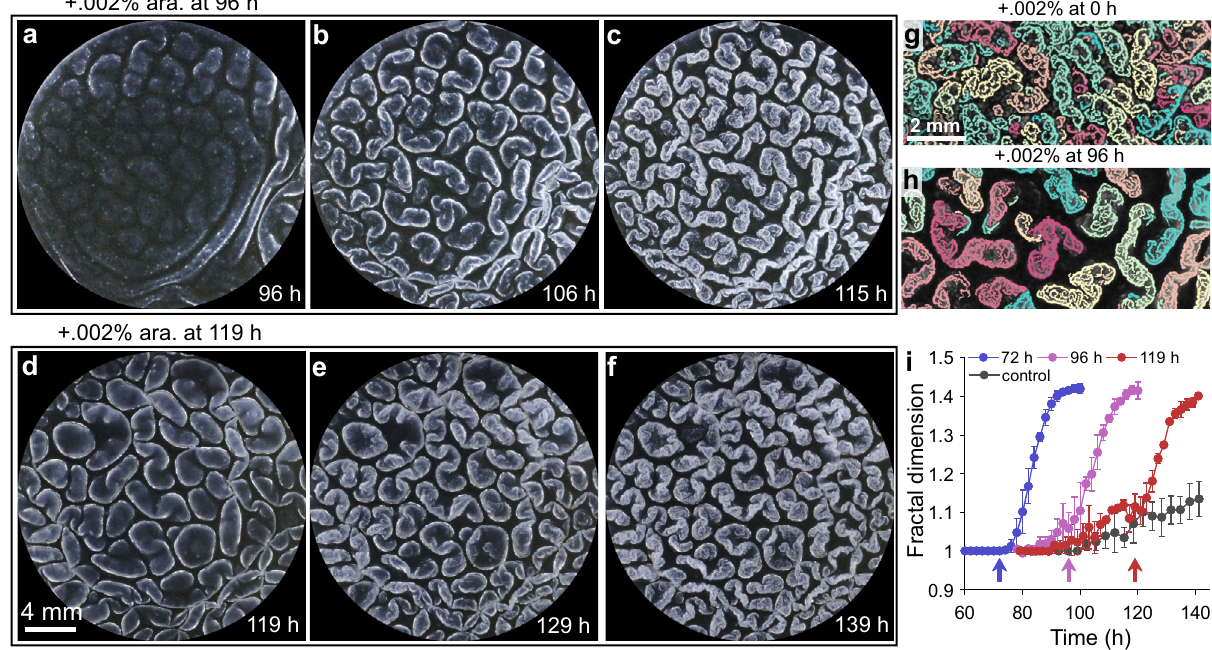
Fig. 4 | Pellicle fractal wrinkling can be triggered on-demand via induction of rbmA expression. a – c Pellicle morphologies of the Rg Δ rbmA strain carrying p rbmA induced with 0.002% arabinose supplied 96h after inoculation, when sec- ondaryridgesbegintoemerge.Imagestakenattheindicatedtimepoints. d – f Asin a – c , with arabinose supplied at119h,following secondary ridgeformation. Images taken at the indicated time points. g , h Segmented pellicle wrinkle features for the Rg Δ rbmA straincarryingp rbmA towhich0.002%arabinosehadbeenadministered